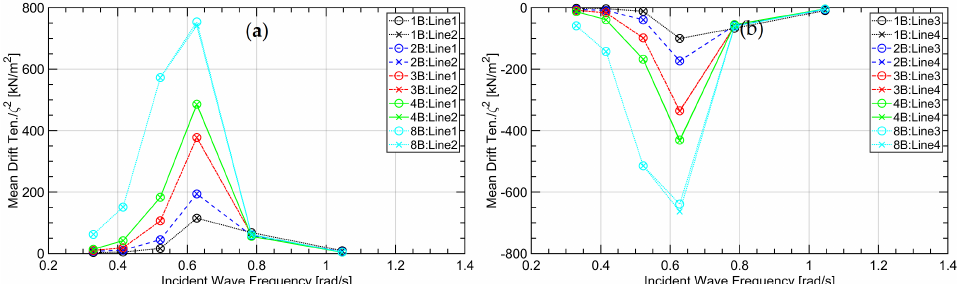
Figure 11. Second-order mean mooring tensions of the five test cases for the chain configuration, where n B denotes the configuration with n bodies; subscript n , the corresponding n -th mooring line: ( a ) line 1 and line 2; ( b ) line 3 and line 4.